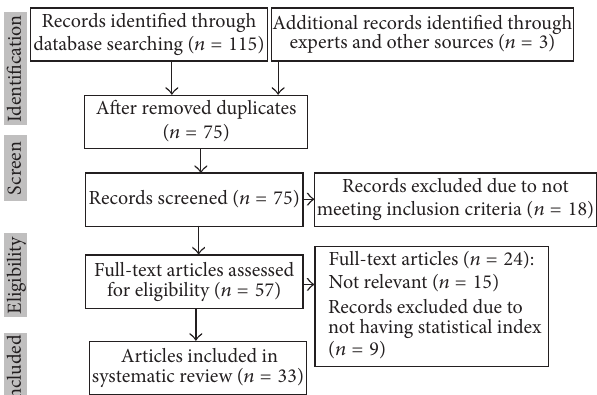
Figure 1: PRISMA flowchart describing the study design process.